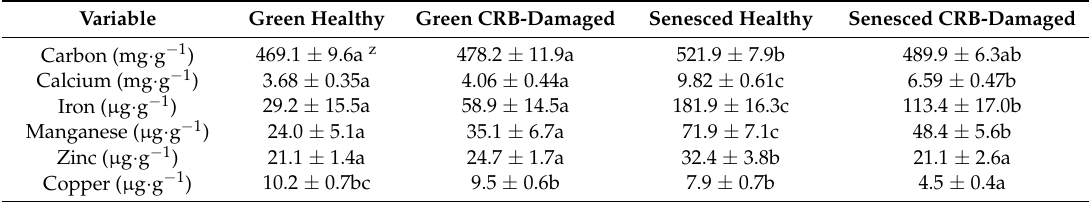
Table 2. The influence of leaf age and coconut rhinoceros beetle (CRB) herbivory on the coconut leaf chemical traits. Mean ± standard error, n = 10.